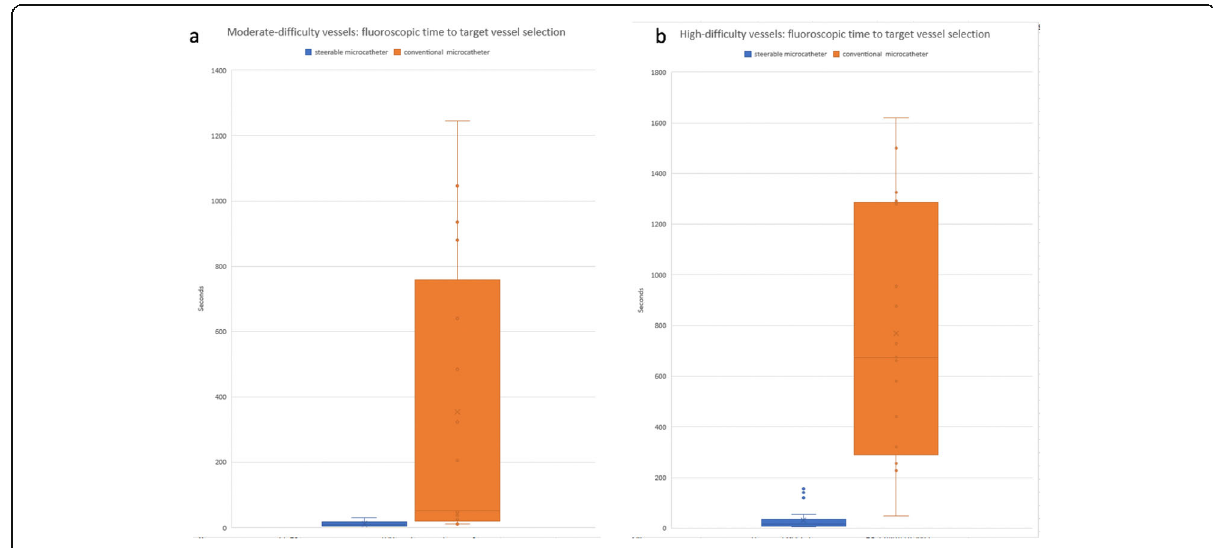
Fig. 2 Distribution of time to target vessel selection in comparison of moderate difficulty ( a ) and high difficulty ( b ) cannulations with steerable microcatheter and conventional microcatheter